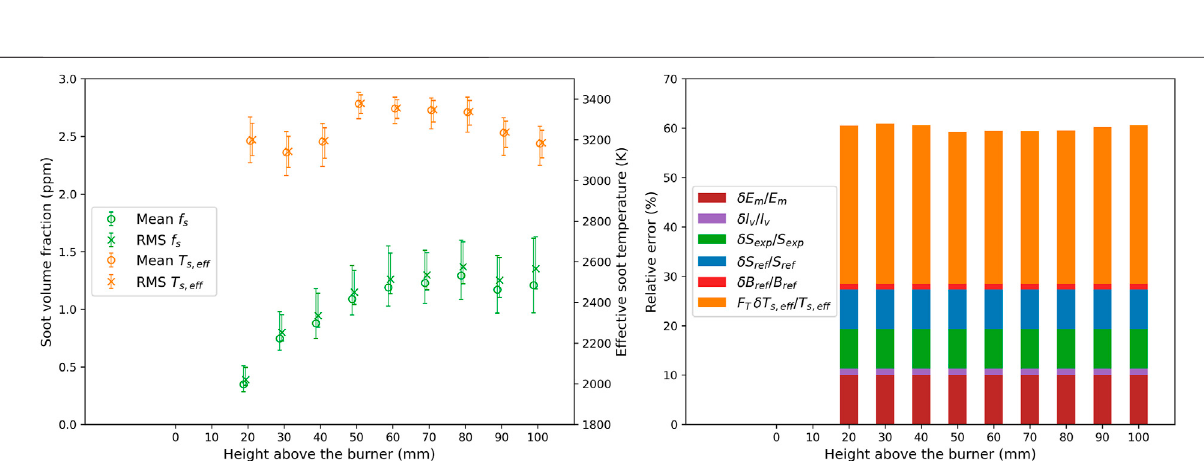
exit (HABs), each sample in a different row. The fi rst column shows the rime-resolved LII signals obtained from measurements by the PMTs at wavelengths of 660 and 810 nm. The second